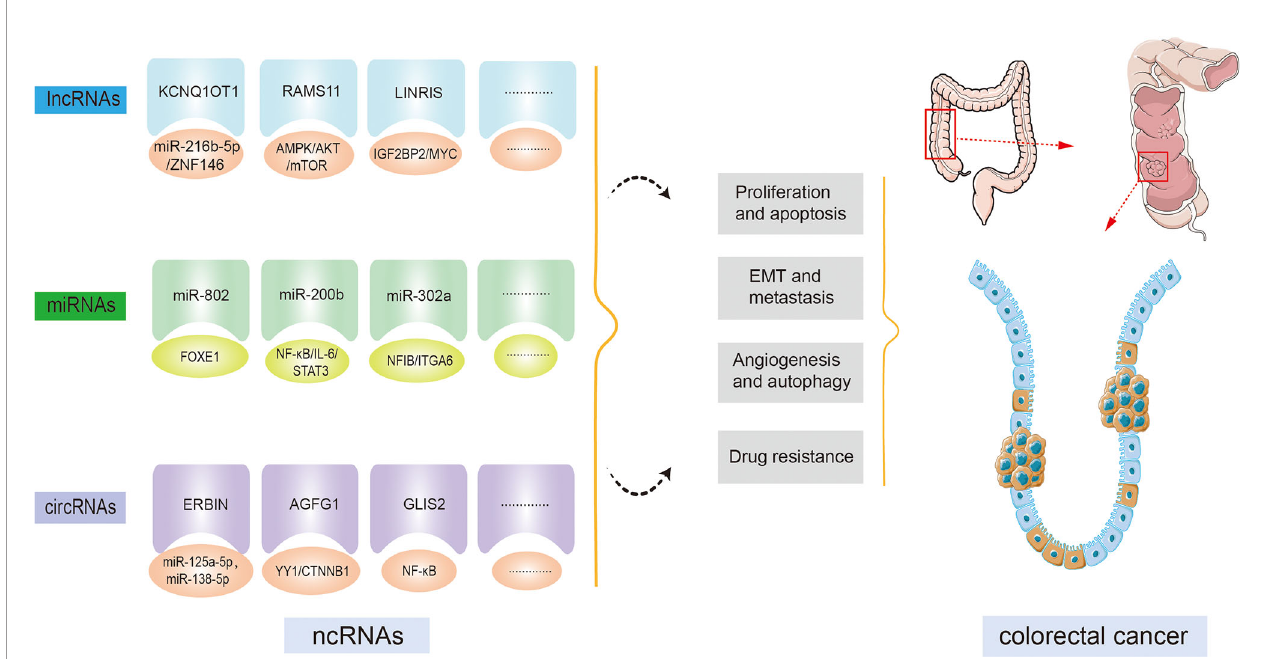
FIGURE 2 | Non-coding RNAs (ncRNAs) regulatory functions in colorectal cancer (CRC) initiation and progression. By targeting downstream molecules or signaling pathways, ncRNAs are involved in CRC cell proliferation, apoptosis, epithelial-mesenchymal transition (EMT), metastasis, angiogenesis, autophagy, drug resistance, and other CRC